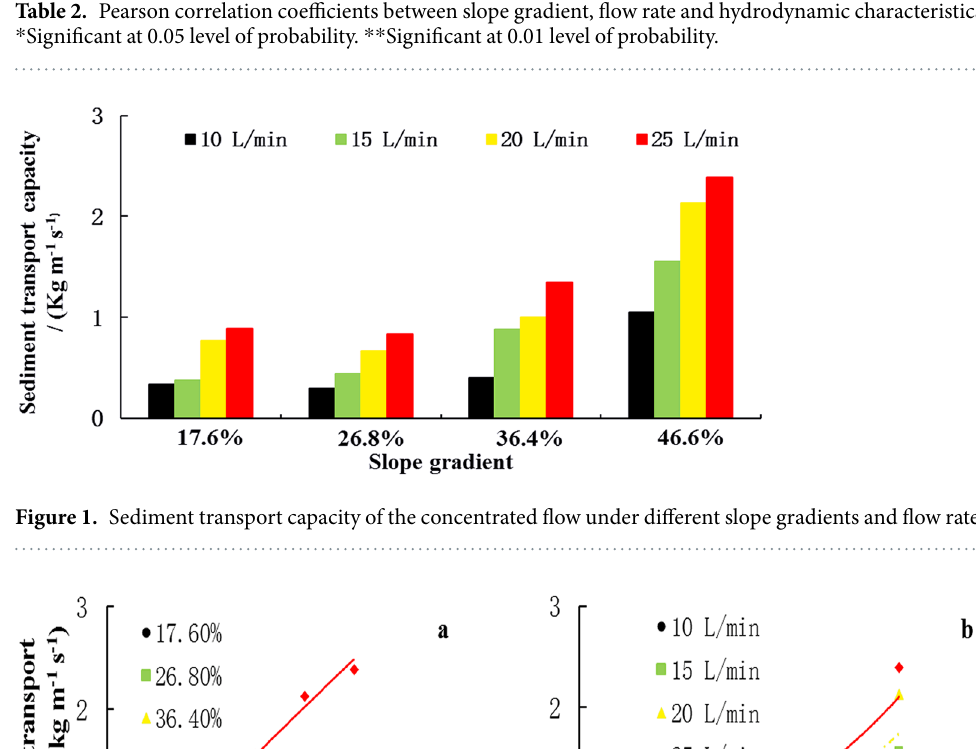
Table 2. Pearson correlation coefficients between slope gradient, flow rate and hydrodynamic characteristics.